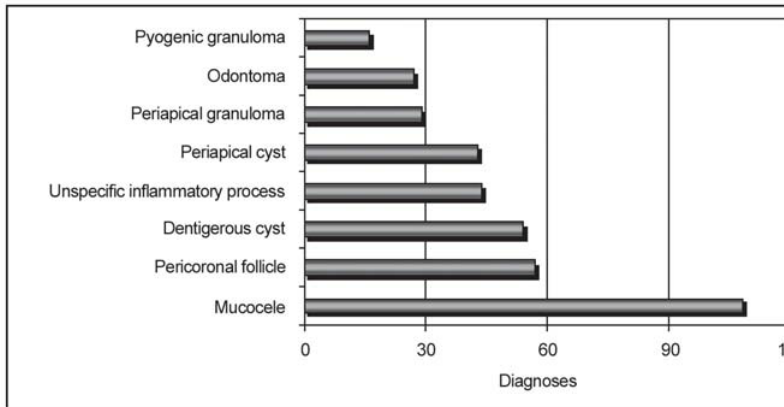
FIGURE 3- Most frequent diagnoses